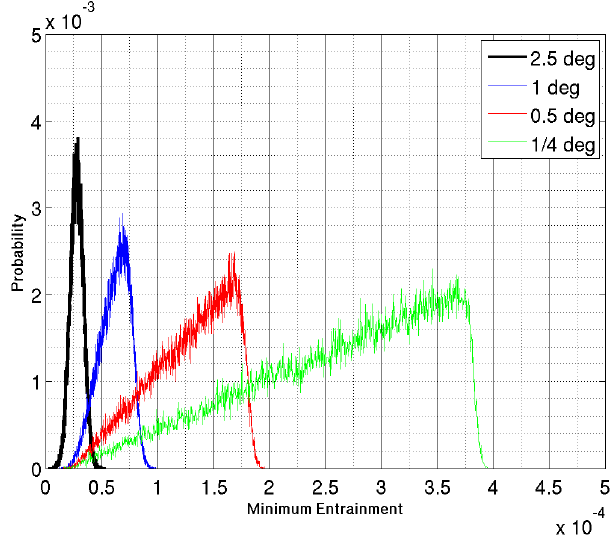
Figure 17. The PDF for the minimum entrainment allowed by the cumulus parameterization for different AGCM horizontal resolu- tions. Black line is for 2 × 2.5 degrees, blue for 1 degree, red for 1 / 2 degree and green for 1 / 4